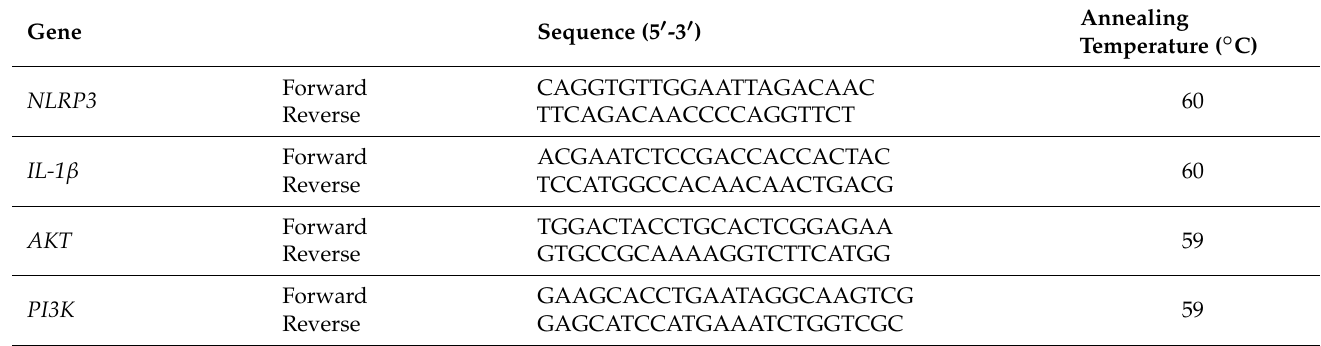
Table 1. Primer sequences with respective annealing temperatures for genes